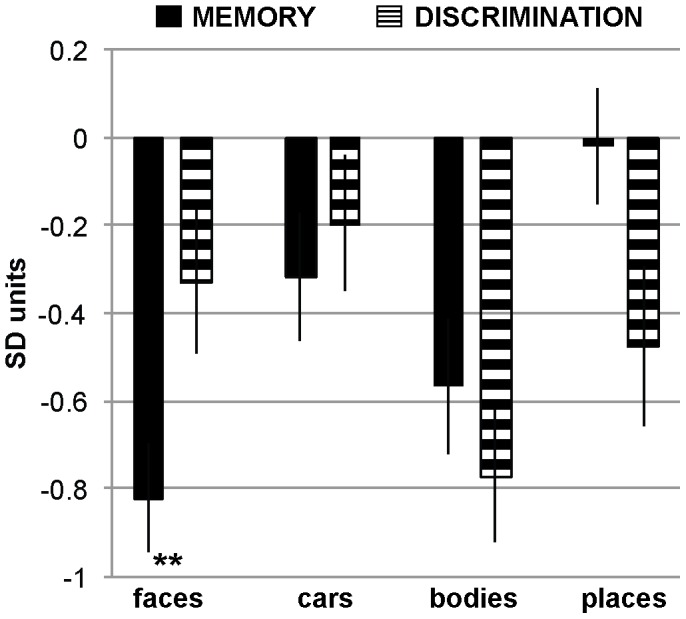
Direct comparison between memory and perception data.Mean across ASD participants of the standardized score for each participant (i.e., the standard deviation of each participant from the typical population) for each stimulus category for memory (left) and perception (right). Values below zero indicate an impairment in ASD. ** denotes p<.01.